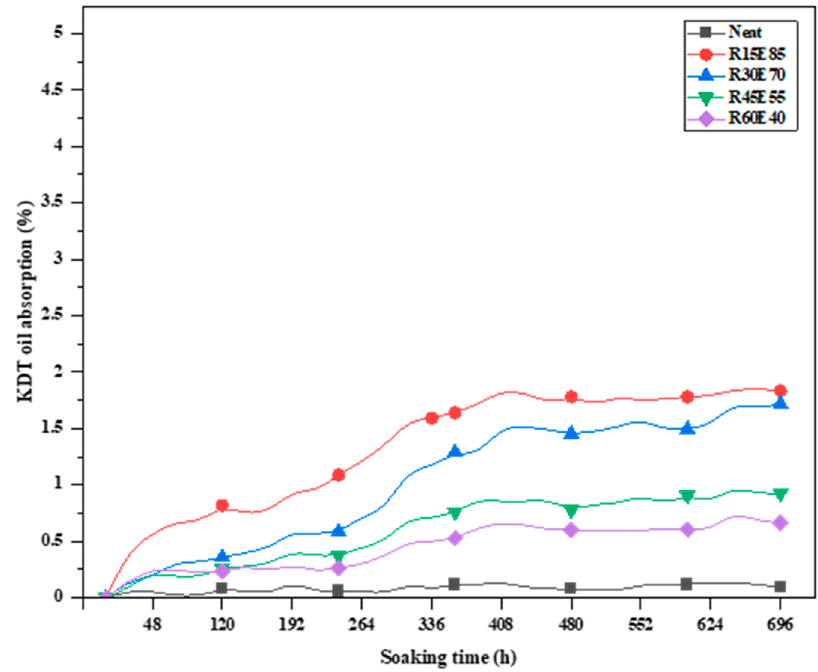
Figure 16. KDT oil absorption rate of the RS p test samples.